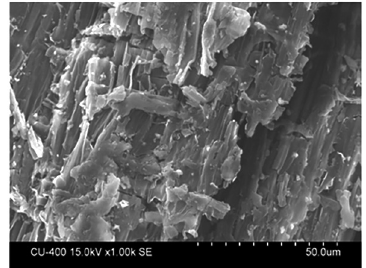
Figure 2. Scanning electron microghaph (SEM) of coconut